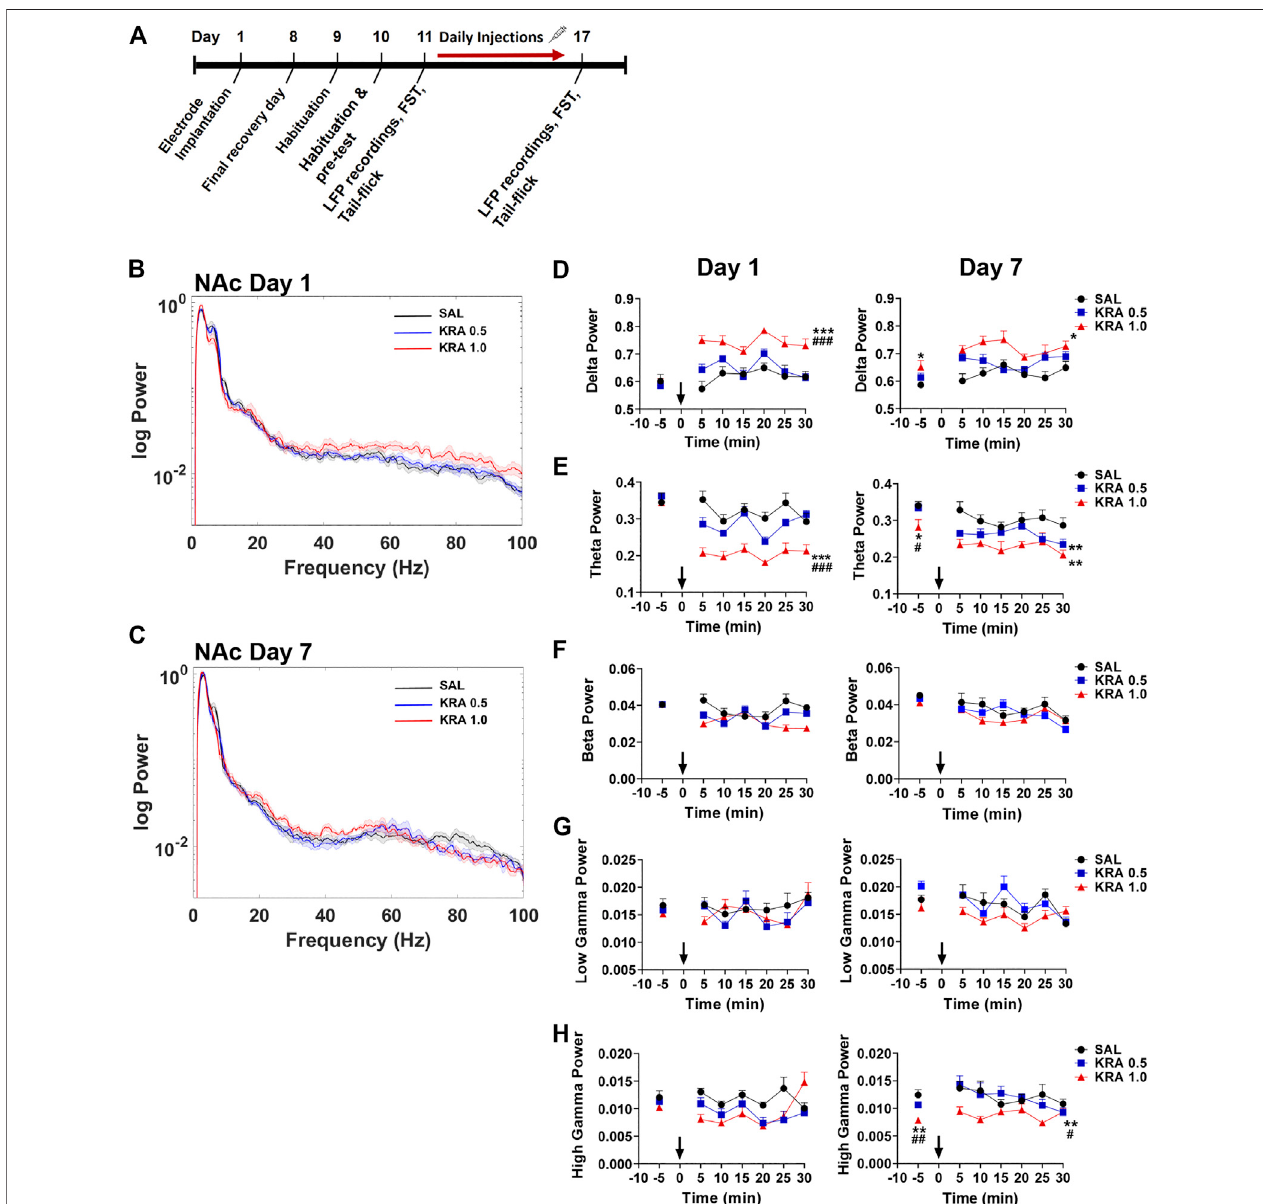
FIGURE 2 | Time course of dose-dependent effects of kratom on NAc spectral power. (A) Experimental timeline is shown. (B,C) Representative power spectra showing dose-dependent (0, 0.5, 1.0 mg/kg) effects of kratom 30 min post-injection on day 1 and day 7. (D) High dose (1.0 mg/kg) kratom increased delta power across 30 min on both day 1 and day 7 with lasting changes observed prior to the fi nal injection of high dose kratom. (E) Only high dose kratom decreased theta power on day 1whereas both doses ofkratom reduced thetapower on day 7. Prior to the fi nal injection a baseline suppression in theta power wasevident in responseto the high dose of kratom. (F,G) No effects of kratom administration on beta or low gamma power were observed on day 1 or day 7. (H) On day 1, no kratom-induced changes in high gamma power were observed. On day 7, high dose kratom decreased baseline high gamma power. This decrease in response to high dose kratom persisted followingthe day 7injection. N (cid:2) 7 – 10 rats per group, with2 electrodes/rat. Curves are represented asmeans withjackknife estimates ofsem depicted by the shaded areas. Barsrepresentmean ± sem. * p < 0.05, ** p < 0.01, *** p < 0.001 compared tosaline control rats. # p < 0.05, ## p < 0.01, ### p < 0.01 compared tolowdose kratom treated